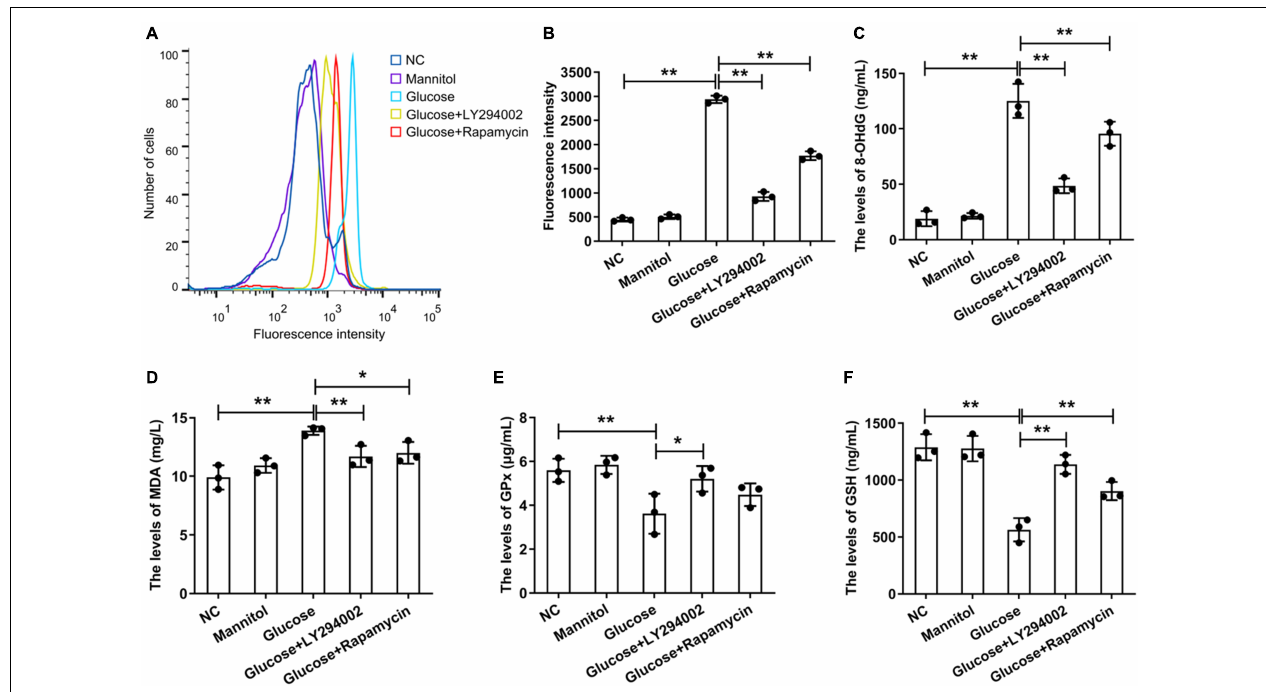
FIGURE 1 | Effects ofLY294002 and rapamycin on HG-induced oxidative stress in rat PMCs. (A) Flow cytometry analysis showed that ROS generation in the HG group and the HG + LY294002 or rapamycin group changed compared with that in the NC group. (B) Statistical analysis of ROS generation, as determined by flow cytometry analysis. The activities of 8-OHdG (C) , MDA (D) , GPX (E) and GSH (F) were analysed by ELISA kits. Columns represent the means ( n ≥ 3); bars represent the SD; * p < 0.05, ** p <